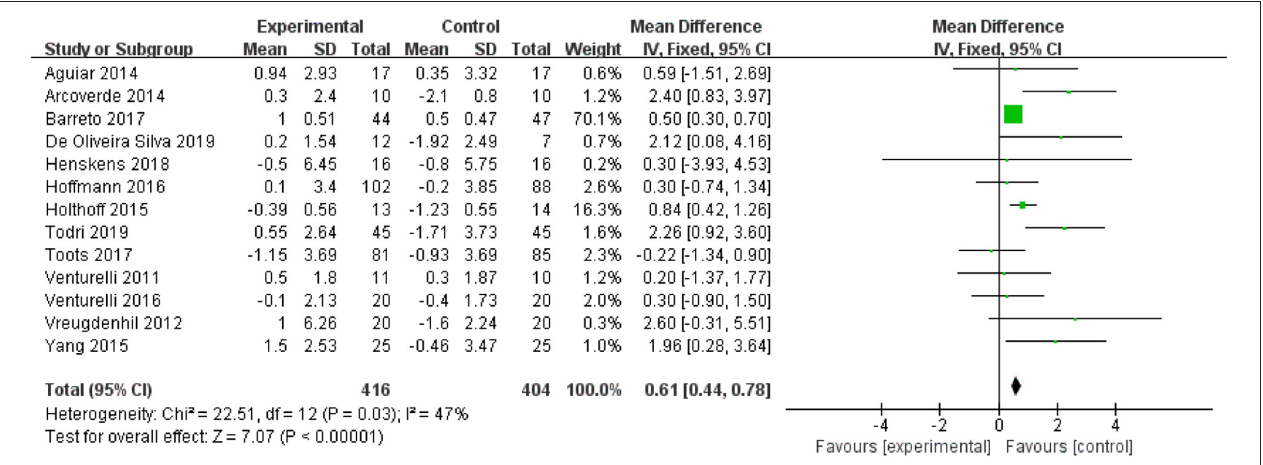
FIGURE 3 | Forest plot for physical exercise interventions on cognition function